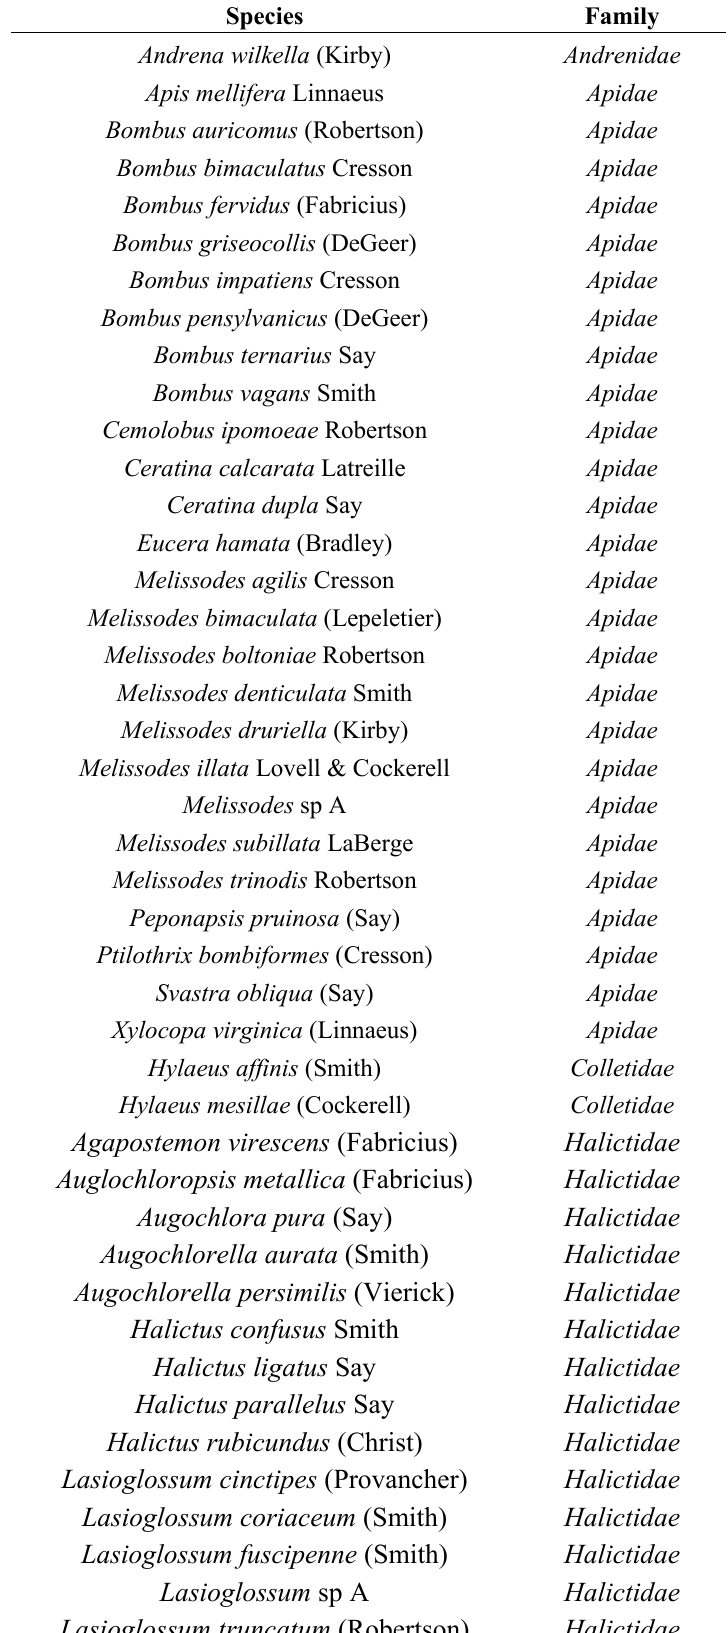
Table A3. A combined species list of all bees collected in conservation grasslands during June and August of 2009 using combination flight-intercept/pan